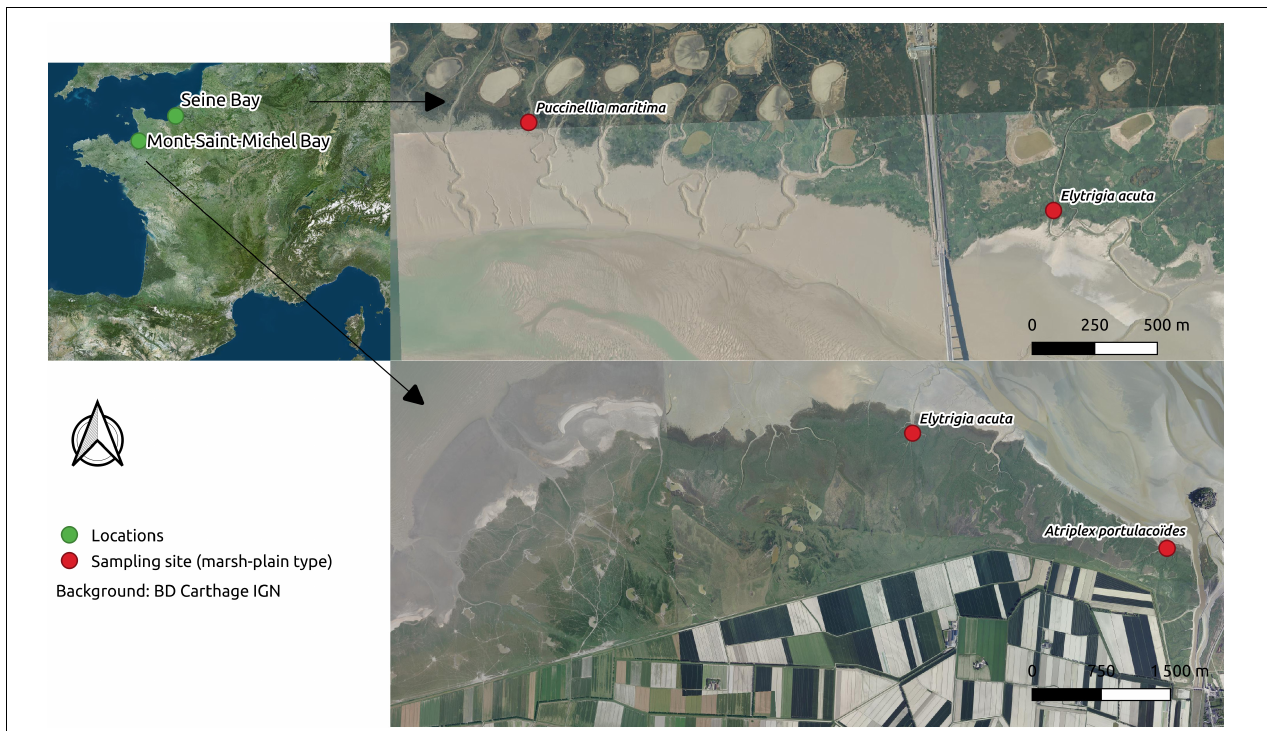
FIGURE 1 | Map of the sampling sites (green dots: Mont-Saint-Michel Bay and Seine Estuary) with sampling locations (red dots with dominant plant species name, referred as marsh-plain type in the